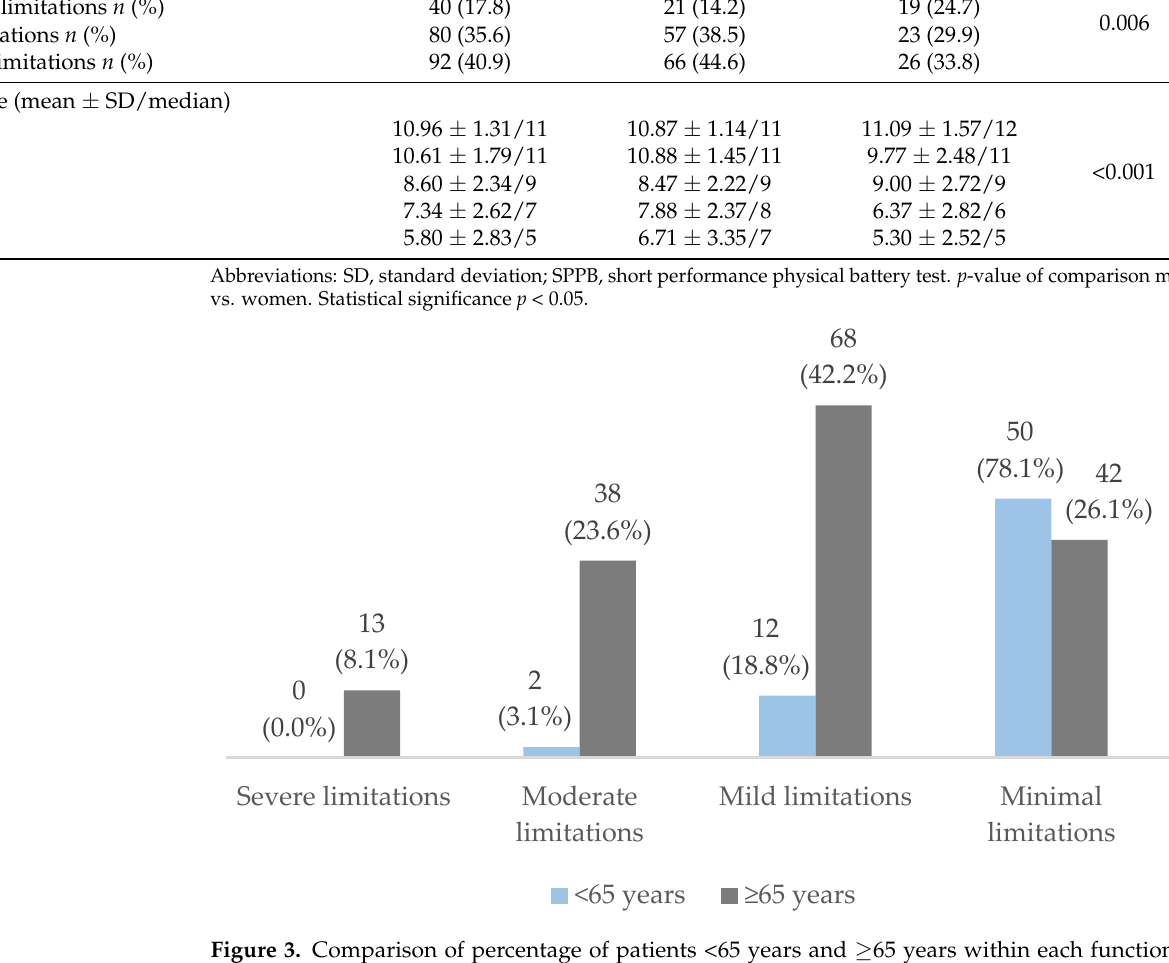
Figure 3. Comparison of percentage of patients <65 years and ≥ 65 years within each functional category assessed with the SPPB test ( p < 0.001).